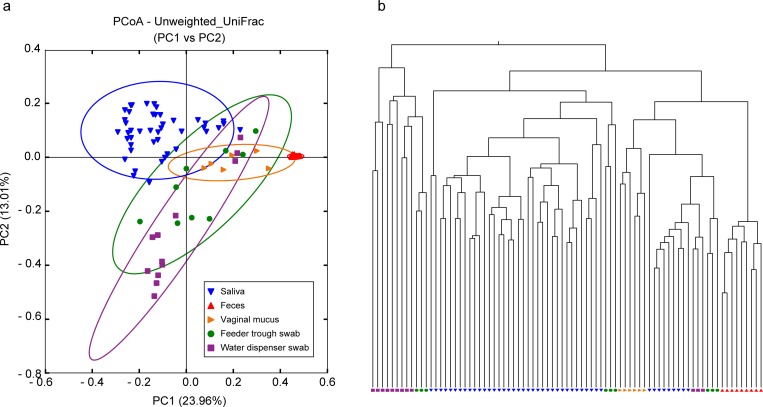
Comparison of microbiota among different sample groups by using β diversity.(a) PCoA measured using unweighted UniFrac distance matrices. The colored ovals show 95% confidence intervals calculated by R. The inset at the lower right shows the symbols and the corresponding samples. (b) The relationship among the microbiota of samples is presented by hierarchical cluster analysis. Symbols at the bottom of the chart are described in the inset in image (a).